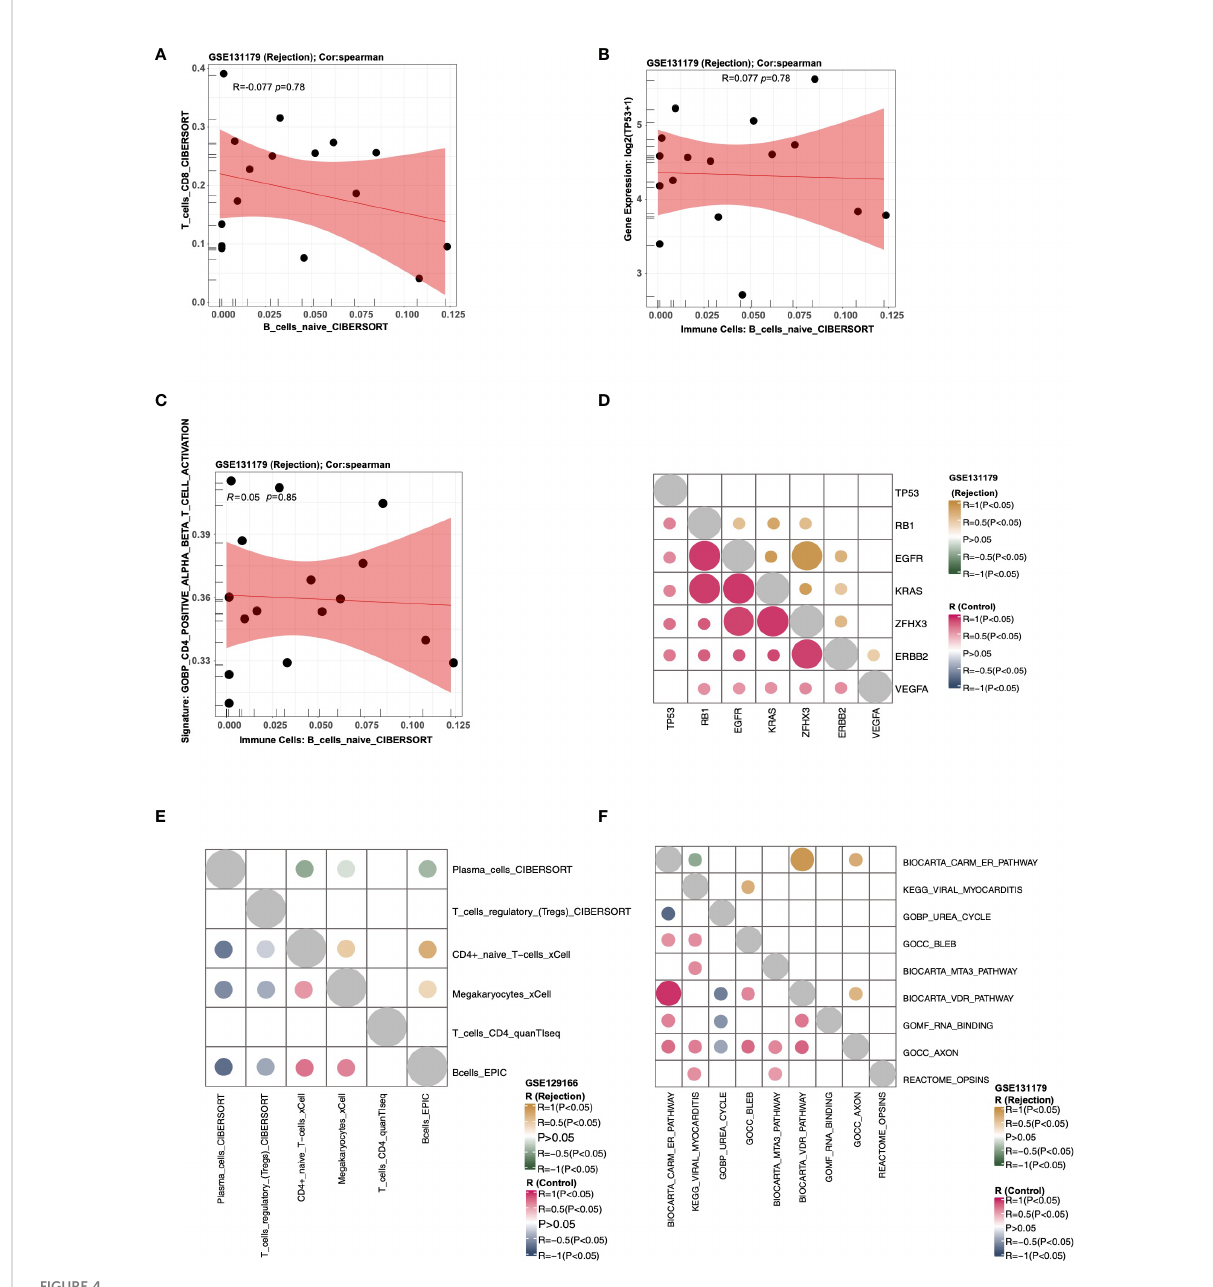
FIGURE 4 An example of the “ Correlation Analysis ” tab. (A) The correlation between the score of T_cells_CD8_CIBERSORT and the score of T_cells_CD8_CIBERSORT in cohort GSE131179 (Rejection samples). (B) The correlation between the score of B_cells_naive_CIBERSORT and the expression of TP53 in cohort GSE131179 (Rejection samples). (C) The correlation between the score of B_cells_naive_CIBERSORT and the score of GOBP_CD4_POSITIVE_ALPHA_BETA_T_CELL_ACTIVATION in cohort GSE131179 (Rejection samples). (D) Heatmap showing the correlation R value and P value among genes TP53, RB1, EGFR, KRAS, ZFHX3, ERBB2, and VEGFA) in the rejection and control groups of the GSE131179 cohort, respectively. (E) Heatmap showing the correlation R value and P value among the immune cells Plasma_cells_CIBERSORT, T_cells_regulatory_(Tregs)_CIBERSORT, CD4+_naive_T − cells_xCell, Megakaryocytes_xCell, T_cells_CD4_quanTIseq, and Bcells_EPIC in the rejection and control groups of the GSE131179 cohort, respectively. (F) Heatmap showing the correlation R value and P value among ssGSEA Pathways BIOCARTA_CARM_ER_PATHWAY, KEGG_VIRAL_MYOCARDITIS, GOBP_UREA_CYCLE, GOCC_BLEB, BIOCARTA_MTA3_PATHWAY, BIOCARTA_VDR_PATHWAY, GOMF_RNA_BINDING, GOCC_AXON, and REACTOME_OPSINS in the rejection and control groups of the GSE131179 cohort,